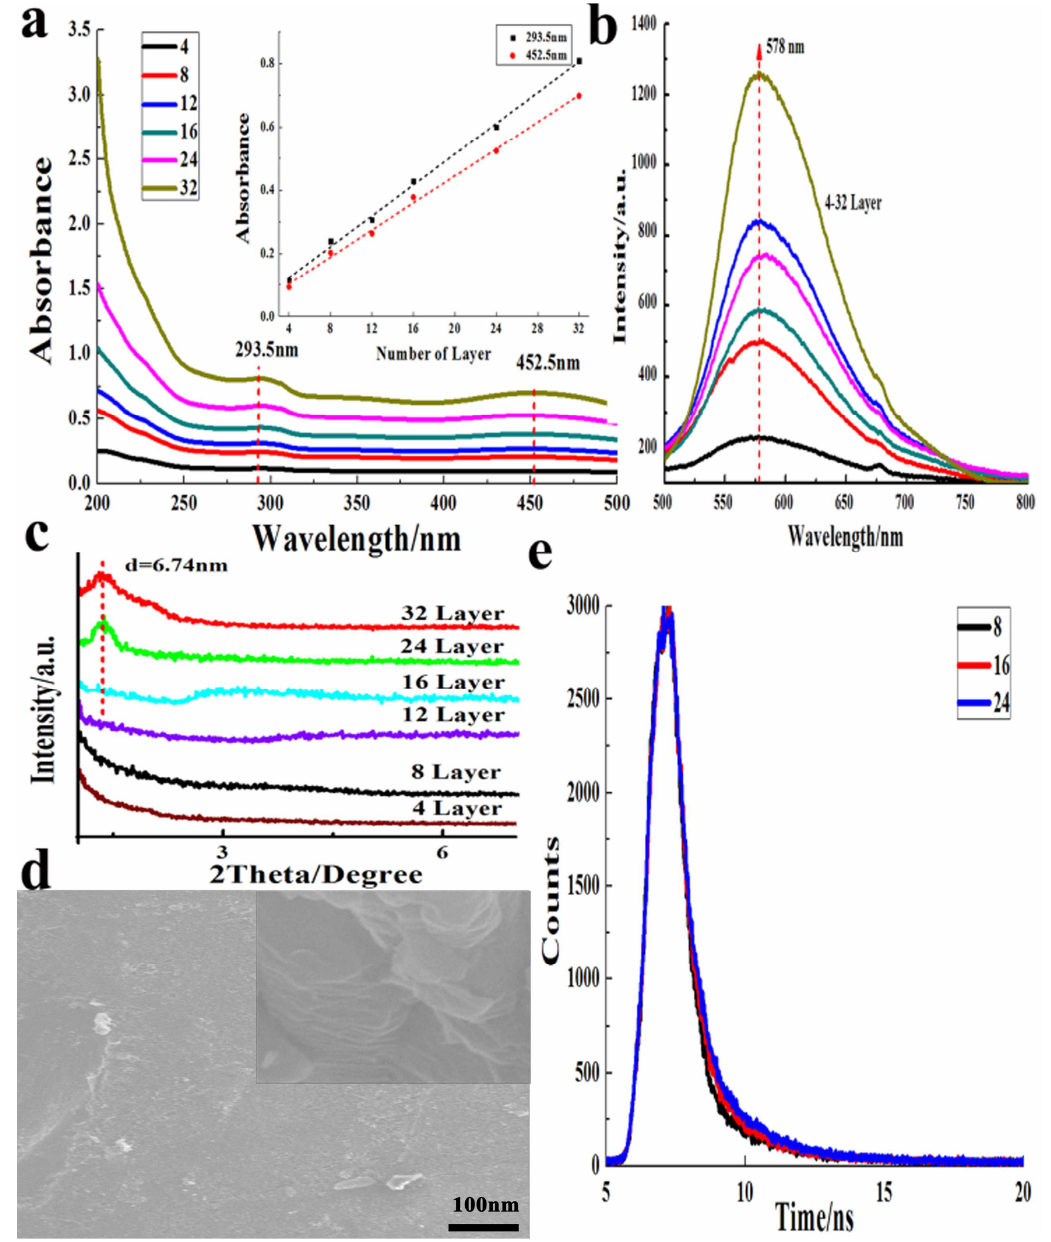
Figure 3. Characterization of (MMT/APPV@PVA/MgAl-LDHs/APPV@PVA) n (MALA(n) films). ( a ) UV-vis absorption spectra (the inset shows the absorbance at 293.5 nm and 452.5 nm increasing linear relationship; ( b ) fluorescence spectra; ( c ) Small angle XRD patterns; ( d ) SEM images of the thin films surface, and the inset show the thin films’ cross sections; ( e ) Fluorescence decay profiles.